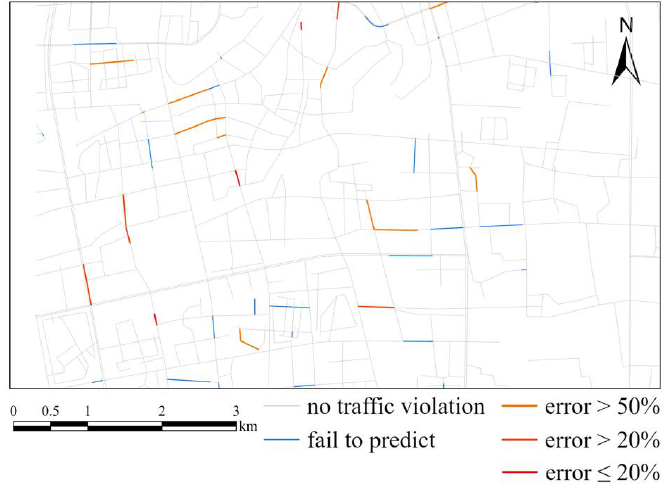
Figure 11. Comparison of GATR and truth. Blue lines represent roads having traffic violations but not predicted by GATR. Red lines represent well predicted roads.